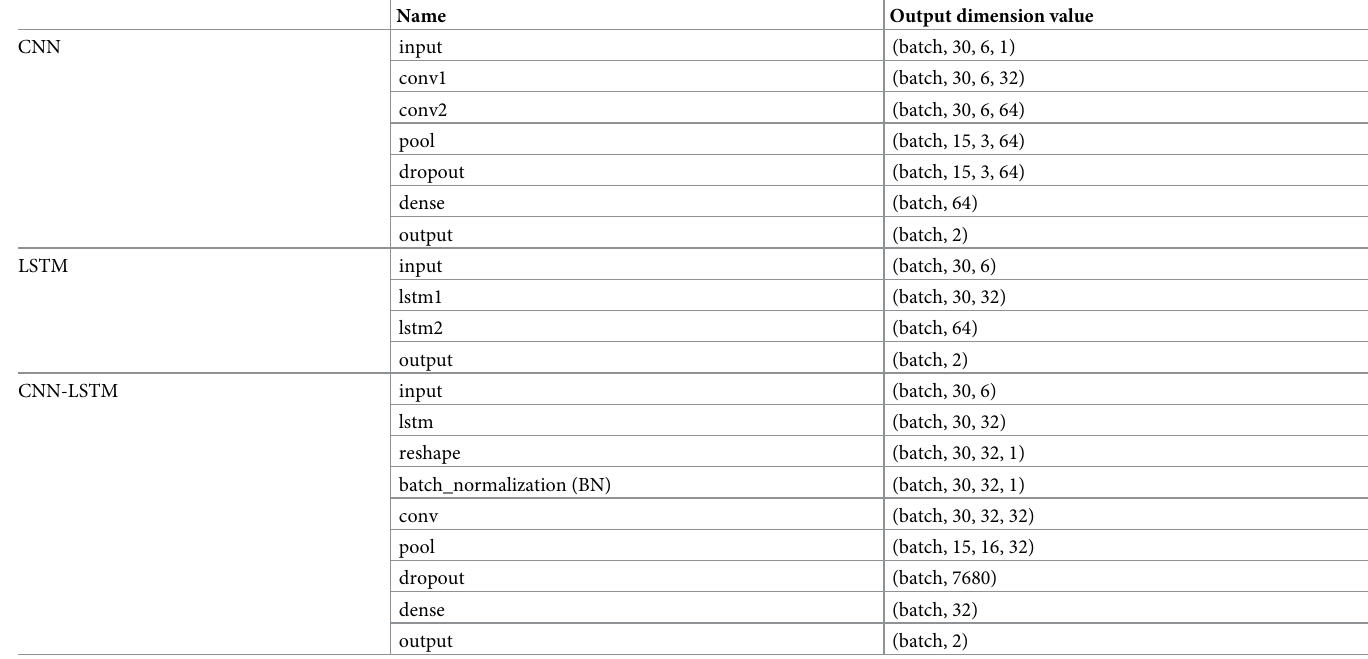
Table 1. Parameter configuration of the CNN, LSTM, and CNN-LSTM